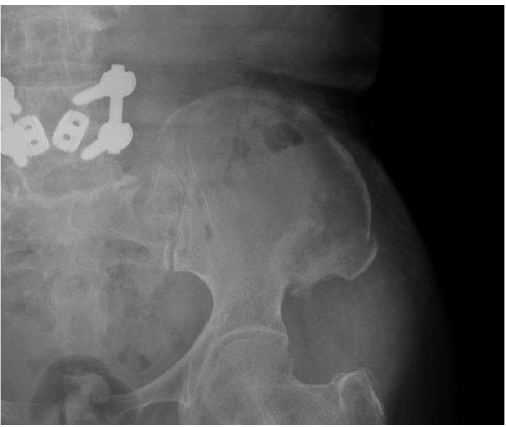
Figure 10. Initial examinations: ( a ) intraoral photograph showed the proliferative lesion with indistinct borders on the right upper gingiva; ( b ) panoramic view.